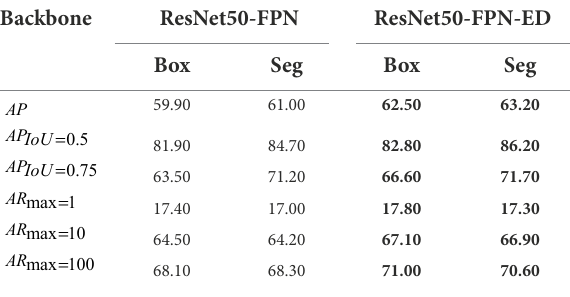
TABLE 5 Performance comparison between the improved Mask R-CNN backbone and the original one on the Grape-A test set.